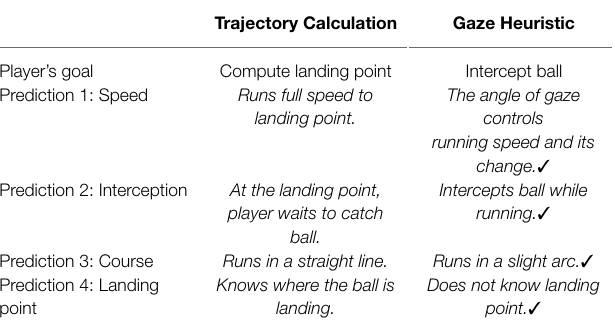
TABLE 1 | The trajectory calculation model and the gaze heuristic make different predictions about both behavior and cognitive processes. In addition, they imply different specifications of the player’s goal. The checkmarks show the predictions supported by experimental